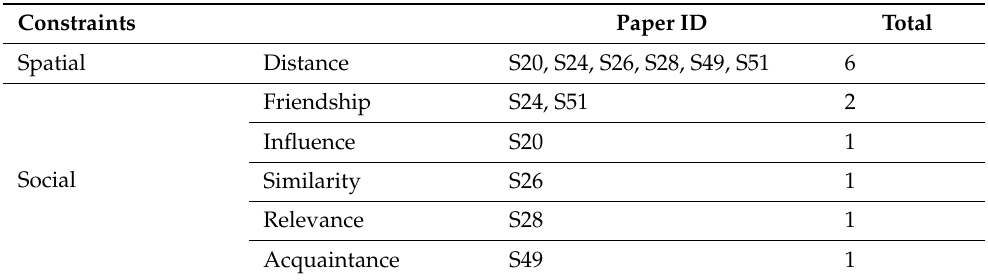
Table 13. Main types of spatial and social constraints applied in geosocial skyline queries. Constraints Paper ID